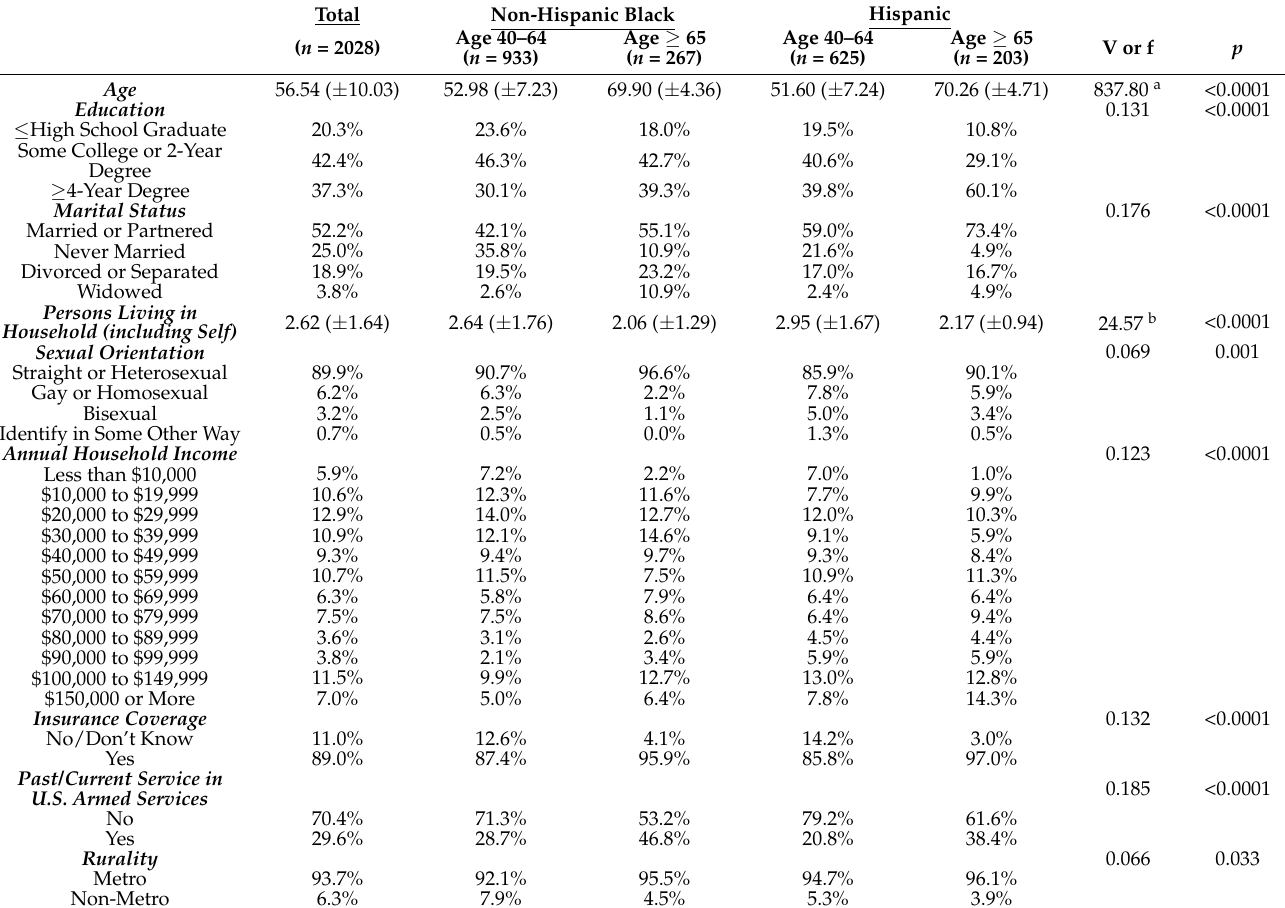
Table 1. Patient context: Sociodemographics by race/ethnicity and